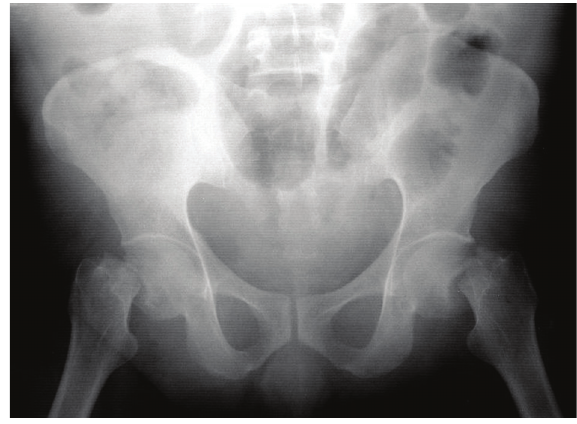
Figure 1: Radiograph of the pelvis showing bilateral fracture of neck of femur.